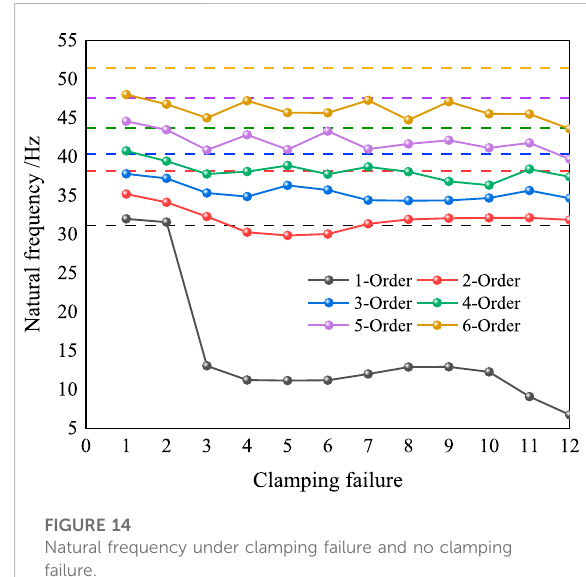
TABLE 8 Failure working conditions.